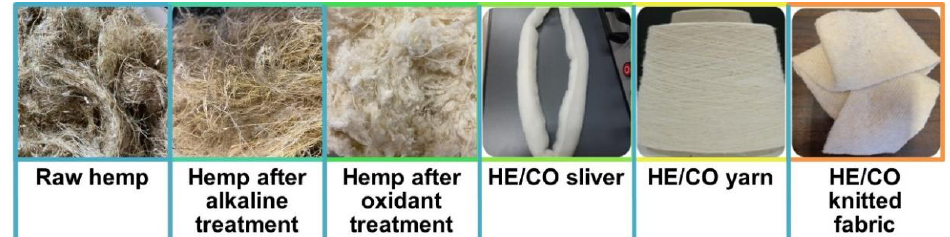
Table 3. The control samples according to UNE-EN ISO 105-C06:2010 A1S.